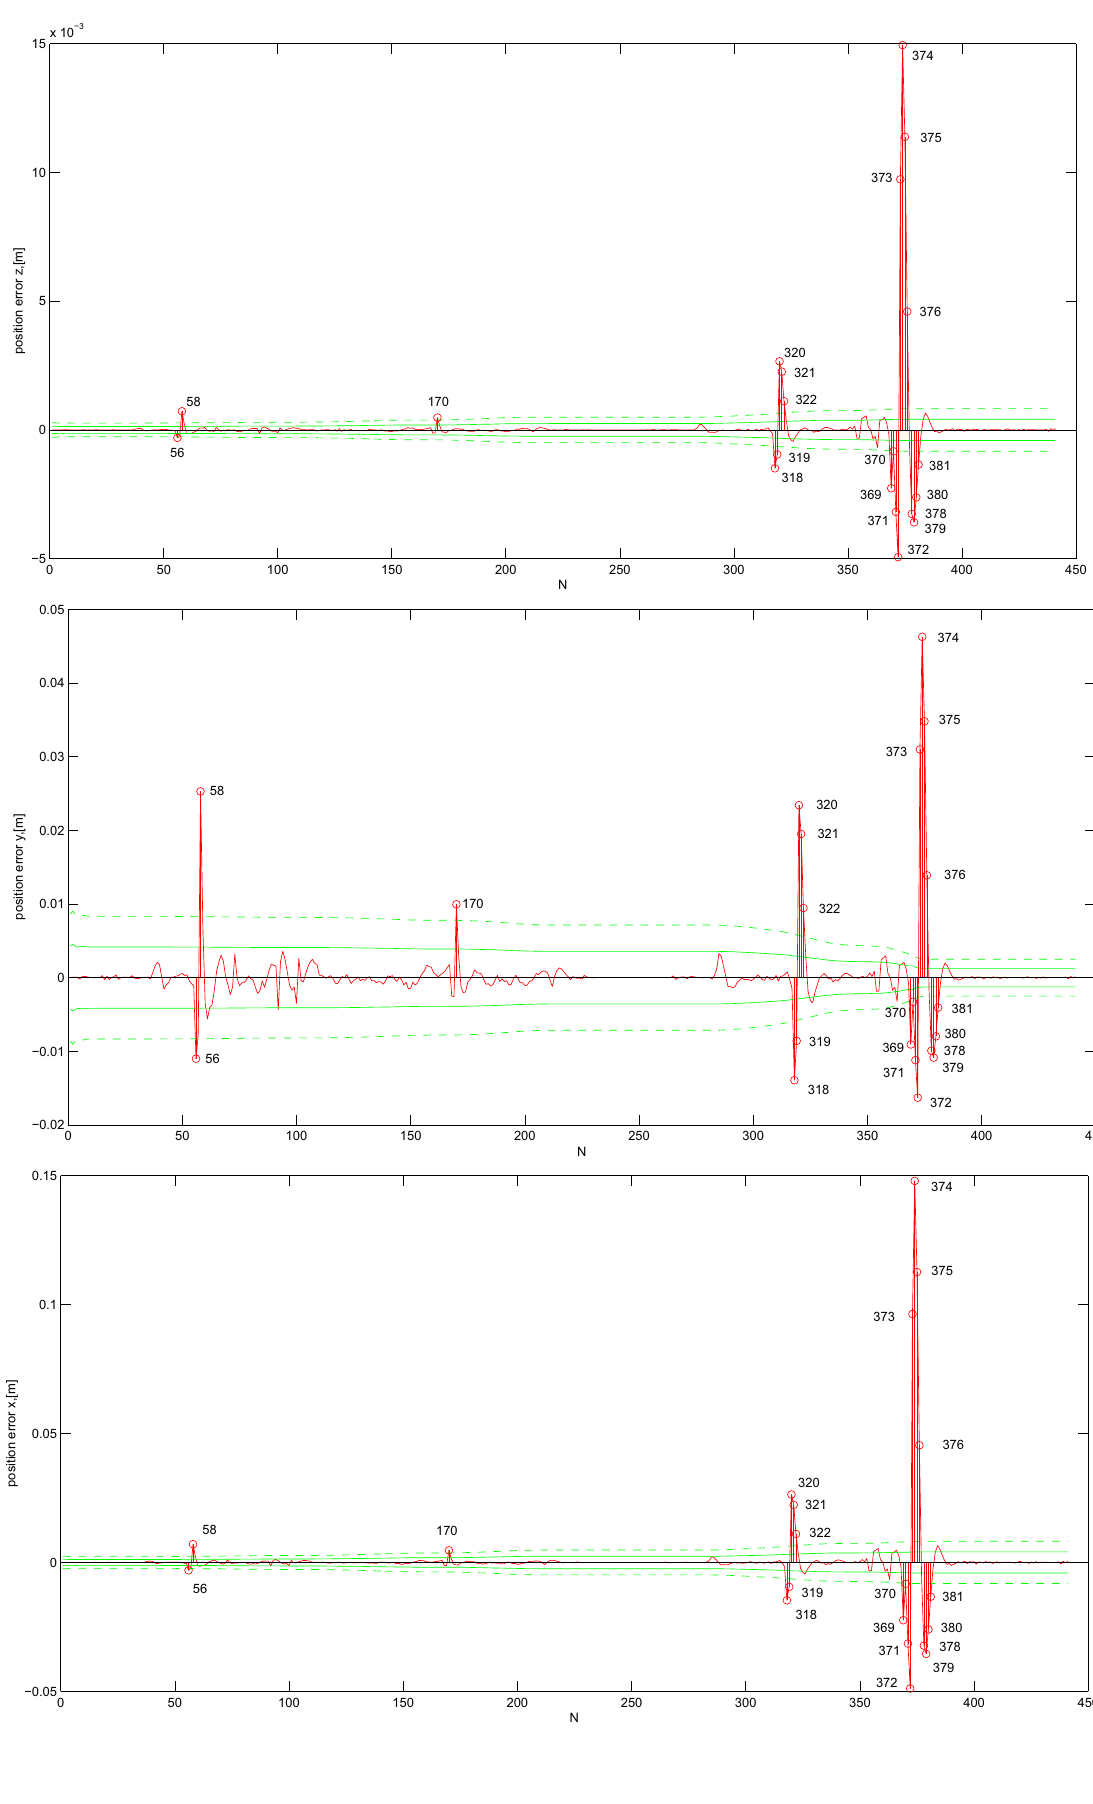
Figure 5. Position